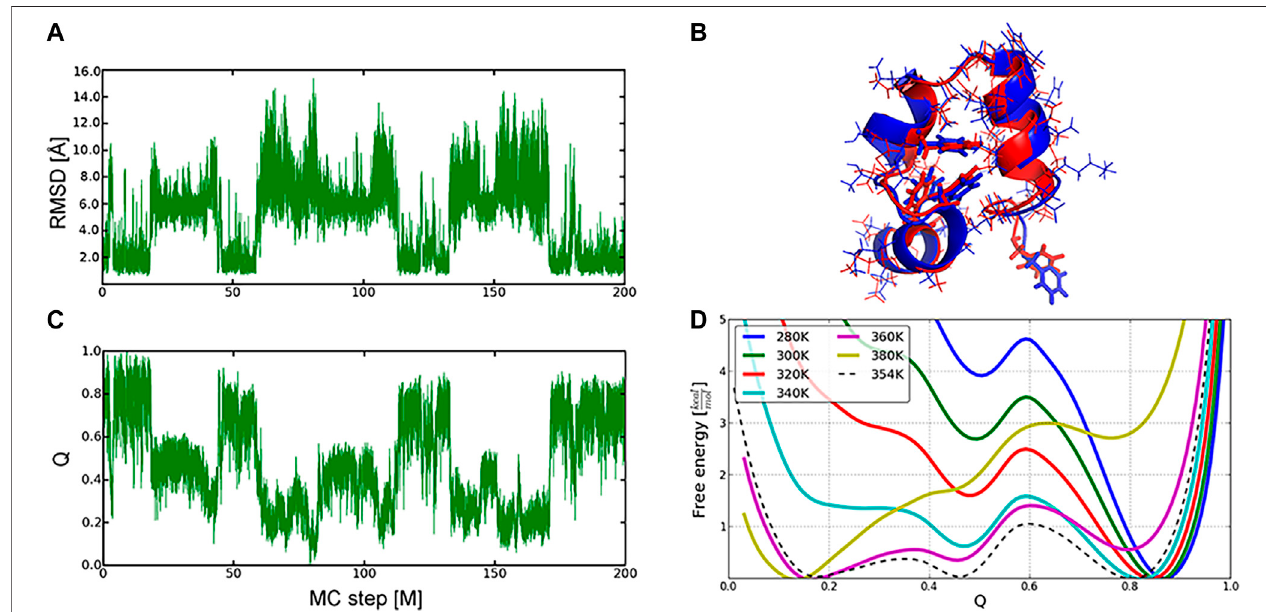
FIGURE 6 | Sampling of the conformational landscape of the Villin headpiece protein (1VII): folding and unfolding events described by RMSD (A) and Q-values (B) changesintheMCrunat360K (C) Overlayoftherefolded(inred,Q − 0.8)andtheexperimental(inblue)conformationoftheprotein (D) ,Freeenergypro fi lesasafunction of Q-values at different temperatures. Native, intermediate, and unfolded ensembles were found at Q ∼ 0.8, 0.45, 0.2, respectively. Graphics reprinted from Heilmann et al. Sci. Rep. 10, 18211 (2020) [52] under Creative Commons Attribution 4.0 International License.